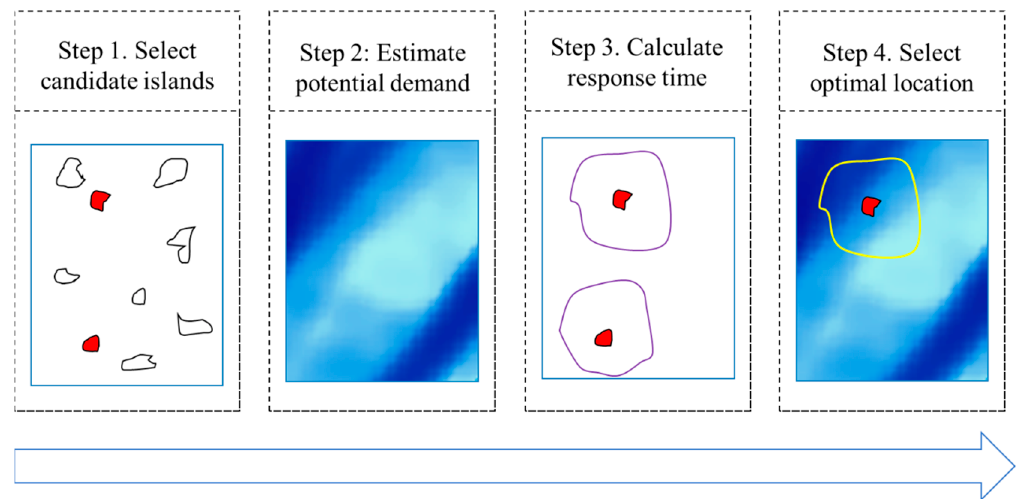
Figure 1. Framework for selecting the location for a maritime search and rescue base.